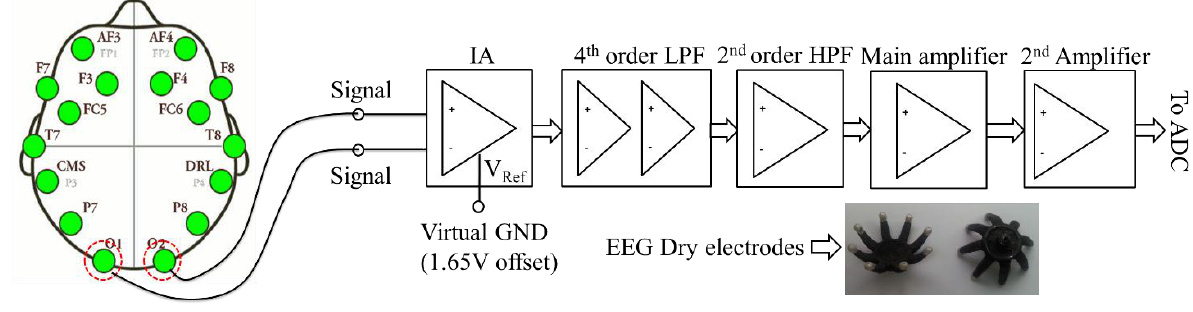
Figure 2. Structure of EEG bio-potentials conditioning circuit and a pair of commercial dry electrodes used. The locations marked by red dotted circles are the locations EEG electrodes attached in this